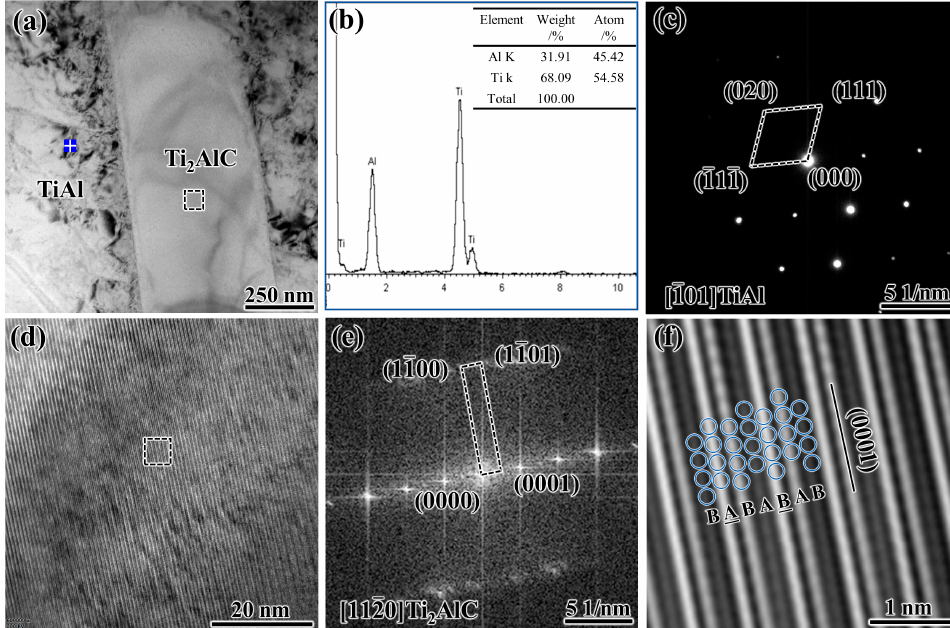
Figure 5. The TEM analysis of the rod-shaped Ti 2 AlC and TiAl in the as-prepared Ti 2 AlC/TiAl composite: ( a ) TEM image; ( b ) EDS analysis of the area marked in ( a ); ( c ) SAED pattern of the area marked in ( a ); ( d ) HRTEM image of Ti 2 AlC; ( e ) FFT pattern of Ti 2 AlC; ( f ) IFFT image of the square area in ( d ).